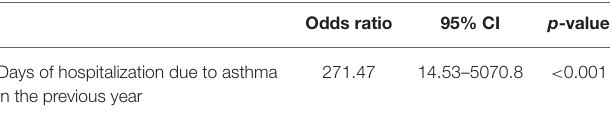
TABLE 5 | Multivariate logistic regression (Dependent variable: Visiting the ED due to asthma attacks followed by hospital admission). Odds ratio 95% CI p -value Days of hospitalization due to asthma 271.47 14.53–5070.8 < in the previous year